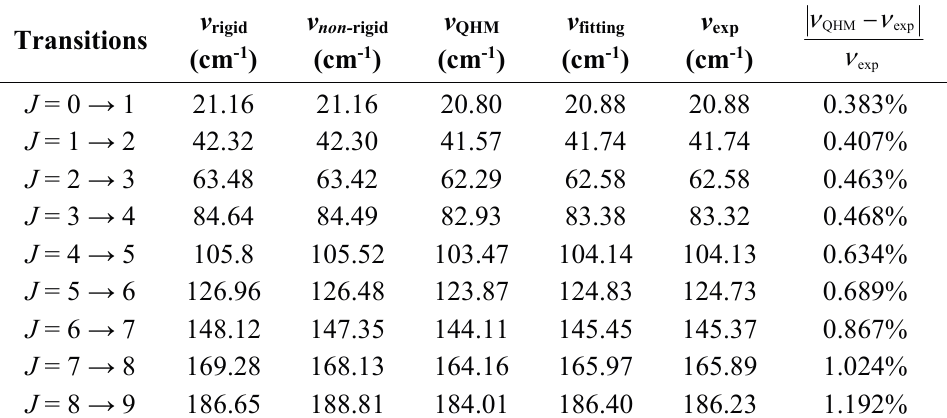
Table 2. Comparisons of the four predictions (cid:2021) measured rotational spectrum (cid:2021)